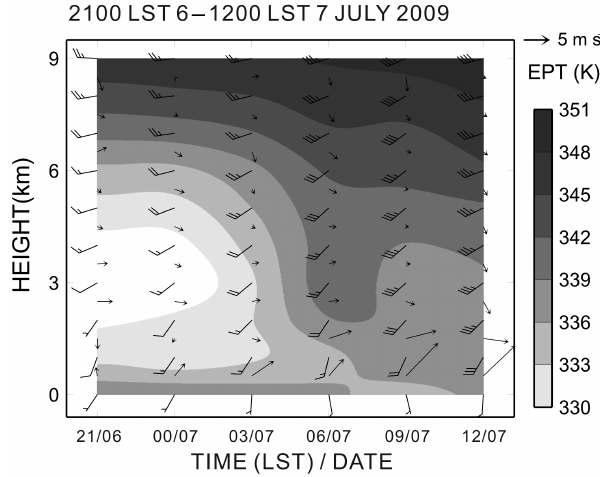
Figure 12. Time–height diagram of horizontal winds (ms − 1 , barbs, full (half) barbs denote 5(2.5)ms − 1 ), vertical wind shear vectors (10 − 5 s − 1 ), and equivalent potential temperature ( θ e , K, shaded), computed as for Fig. 11 from 21:00LST 6 to 12:00LST 7 July